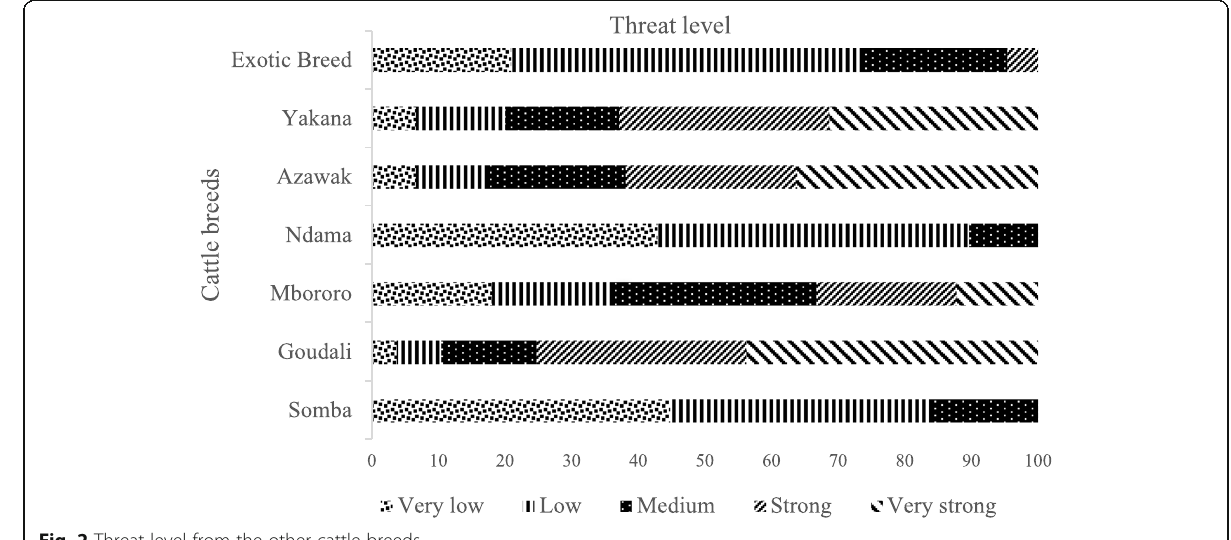
Fig. 2 Threat level from the other cattle